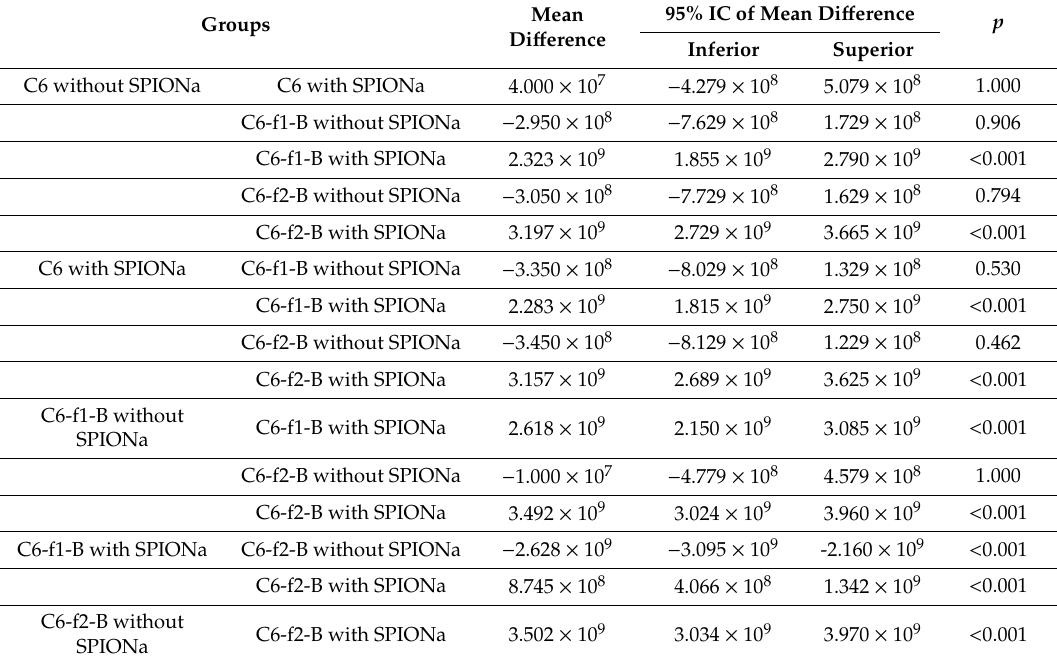
Table A2. Post Hoc analysis of the BLI signal of experimental groups in the first MHT application. Groups